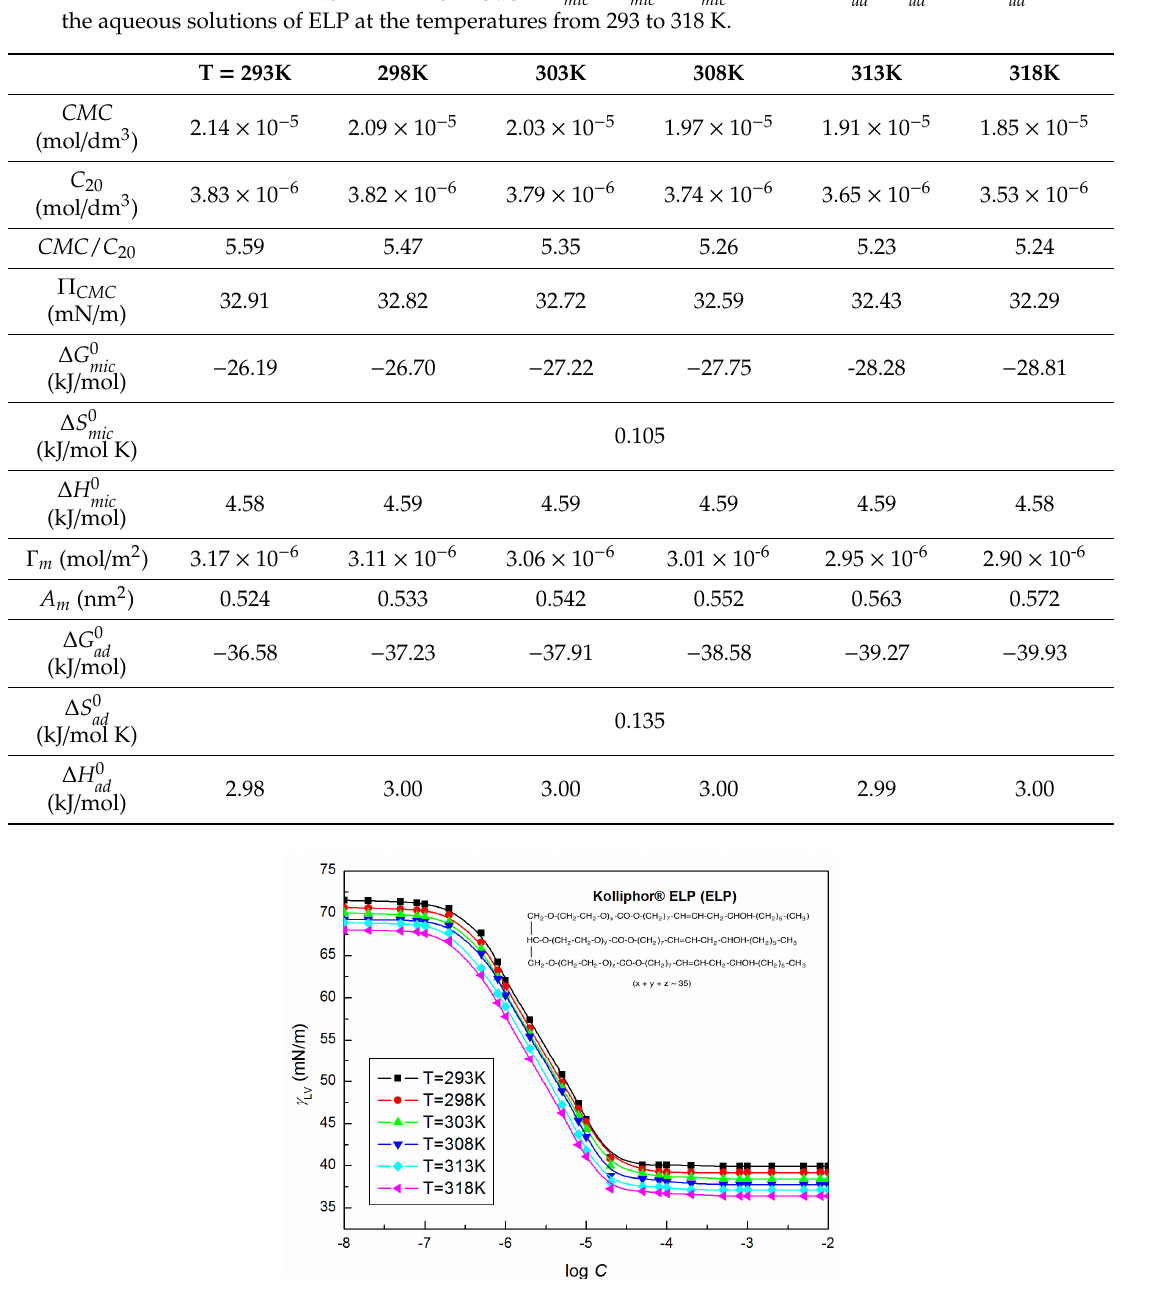
, ∆ S 0 , ∆ H 0 , Γ m , A m , ∆ G 0 mic mic mic